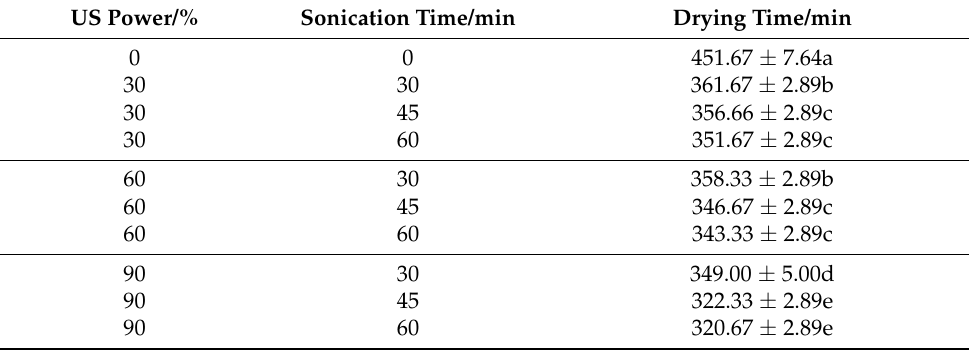
Table 6. Relationship between the ultrasonic parameters and drying time.